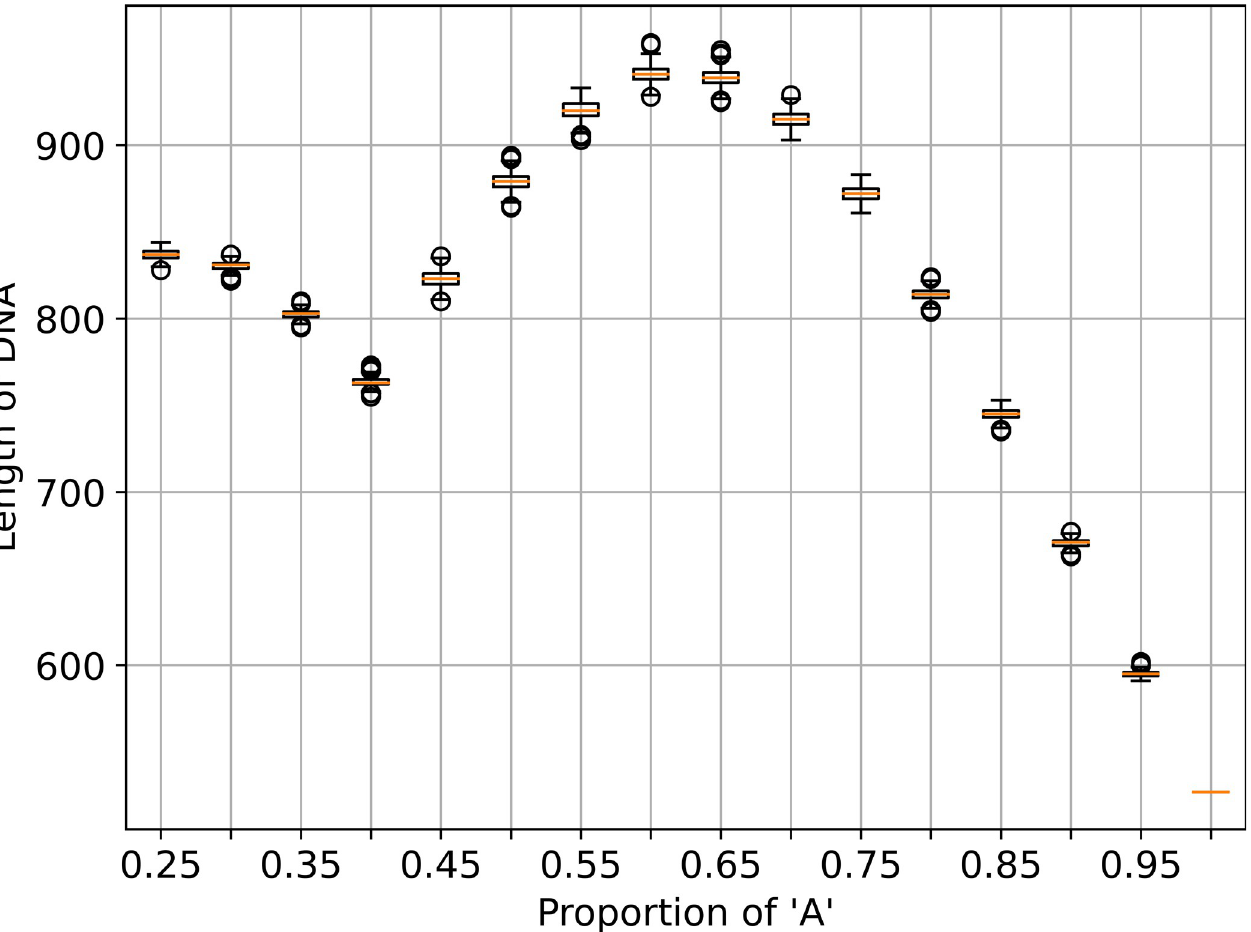
Fig 3. The length threshold of DNA sequence for successful compression using DDQR. The x-axis shows the DNA compositions. The y-axis shows the length of DNA sequences.